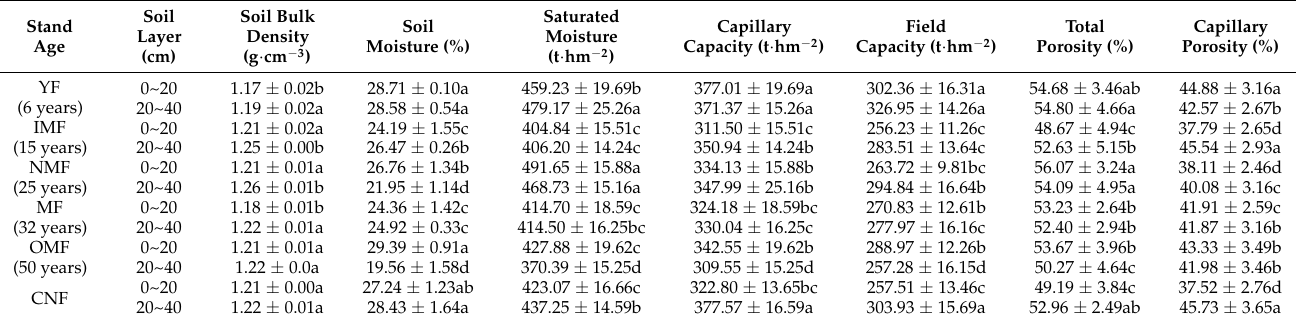
Table 2. General soil physical properties at the Experimental Center of Tropical Forest, China. Properties were average values measured in soil samples taken from each replicate plot in 2018 ( n = 9). p -values within each column were determined by ANOVA. Different lowercase letters between different stand ages in the same soil layer indicated significant differences as determined by Tukey’s HSD test ( α = 0.05). The same